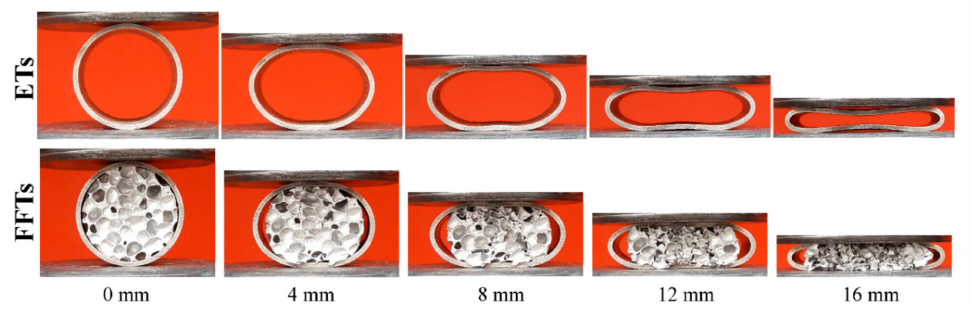
Figure 3. Deformation sequences of ETs and FFTs under LL quasi-static compression loadings.